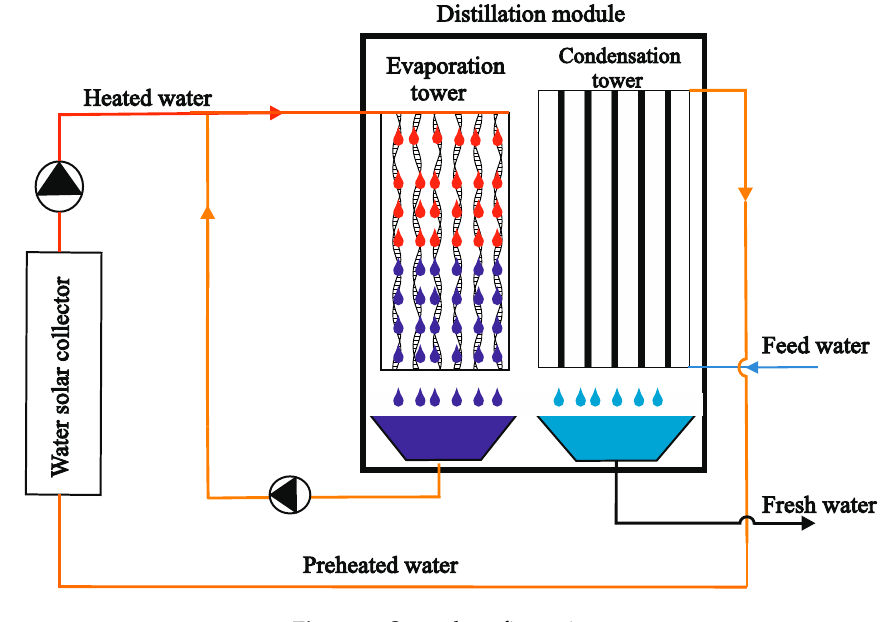
Figure 2. Second configuration.